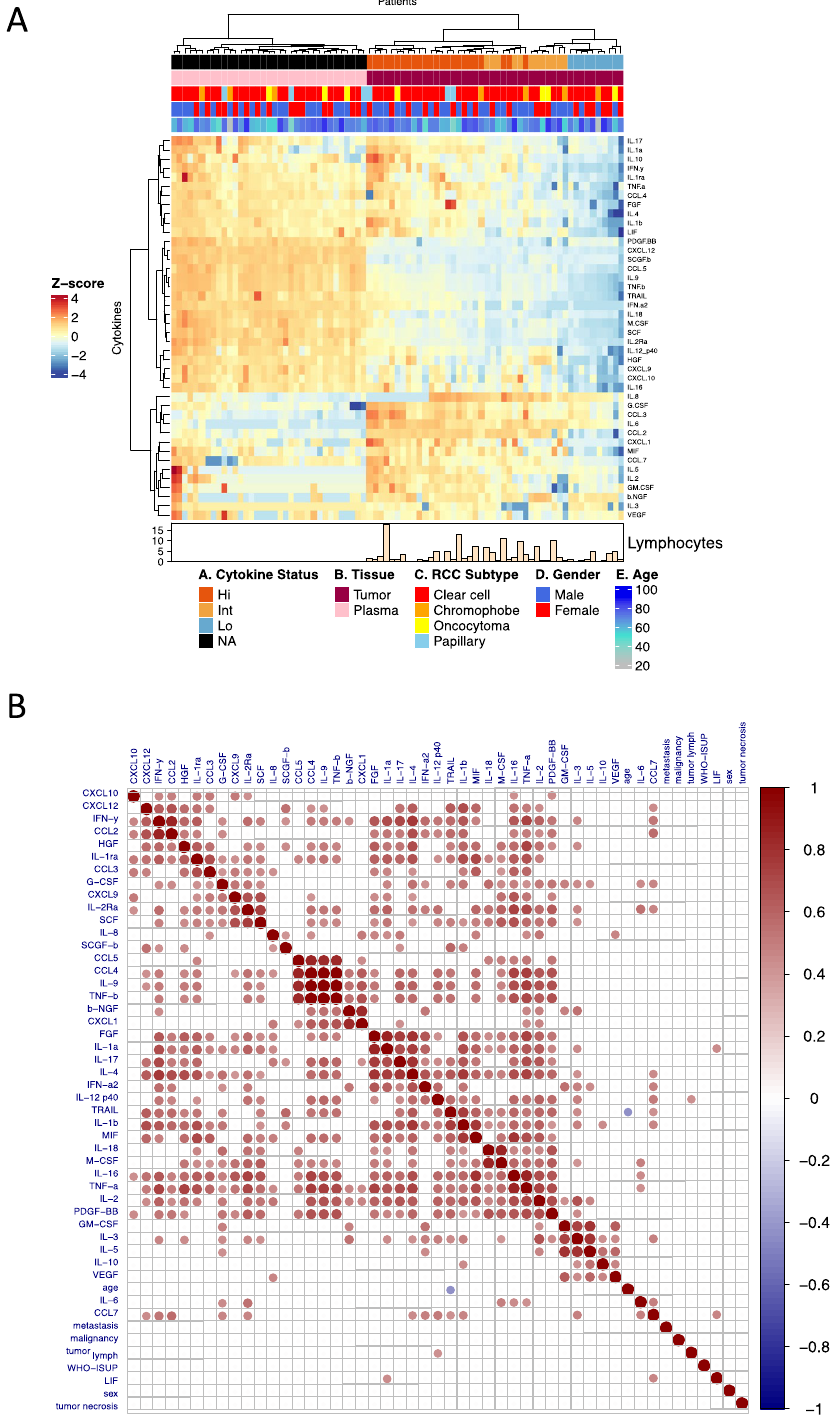
Figure 4. ( A ) Heatmap showing the circulating cytokine expressions from 33 matching plasma samples together with all tumor samples (n = 46). Unsupervised clustering showed markedly distinct clustering between the cytokine profiles of the different sample types, but no differences were observed with the clinical parameters. ( B ) Correlation plot of the plasma cytokines and various tumor clinical parameters such as the WHO/ISUP 2016 tumor grading, metastasis development, tumor malignancy, abundance of tumor lymphocytes, presence of necrosis in the tumor tissue, age, and gender of the patients. The quantity of the tumor lymphocytes was positively correlated with plasma IL-12 (p40) expression (Supplementary Fig. S6D). The full list of clinical parameters is found in Supplementary Table